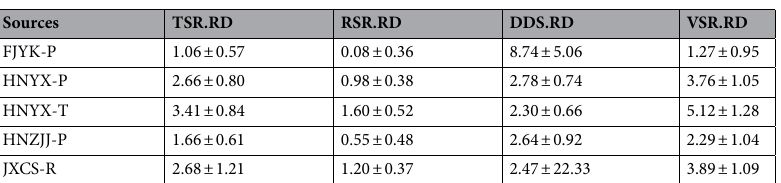
Table 1. The statistical analysis of shrinkage (air-dry) of Chinese fir. Data are means ± SE. TSR.RD Tangential shrinkage rate of air-dry density, RSR.RD Radial shrinkage rate of air-dry density, DDS.RD Difference dry shrinkage of air-dry density, VSR.RD Volume shrinkage rate of air-dry density.